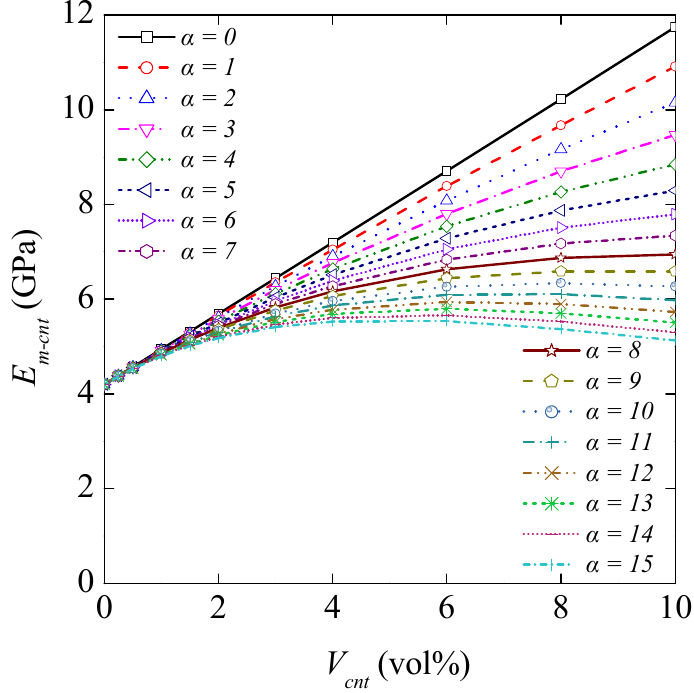
Figure 8. Young’s modulus of CNT ‐ reinforced matrix as a function of V cnt (vol%) for various f A agglomeration factors calculated from the equation f A = exp( −α V β cnt ), where α ranges from 0 to 15 and β = 0.9. Young’s modulus of MWCNT/polymer composite obtained from the modified Halpin–Tsai model concerning the following properties: E m = 4.20 GPa, E cnt = 900 GPa, L cnt = 2000 nm, d cnt = 30 nm, f W = 0.6, and f R = 1/6.